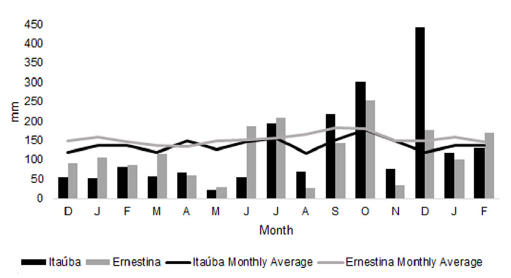
Figure 2. Total monthly rainfall (bars) and average pluviometric levels (lines) between December 2011 and February 2013. Data were obtained from the Passo Fundo Meteorological Station, in the Ernestina reservoir drainage area, and from the Cruz Alta Meteorological Station, located in the Itaúba reservoir drainage